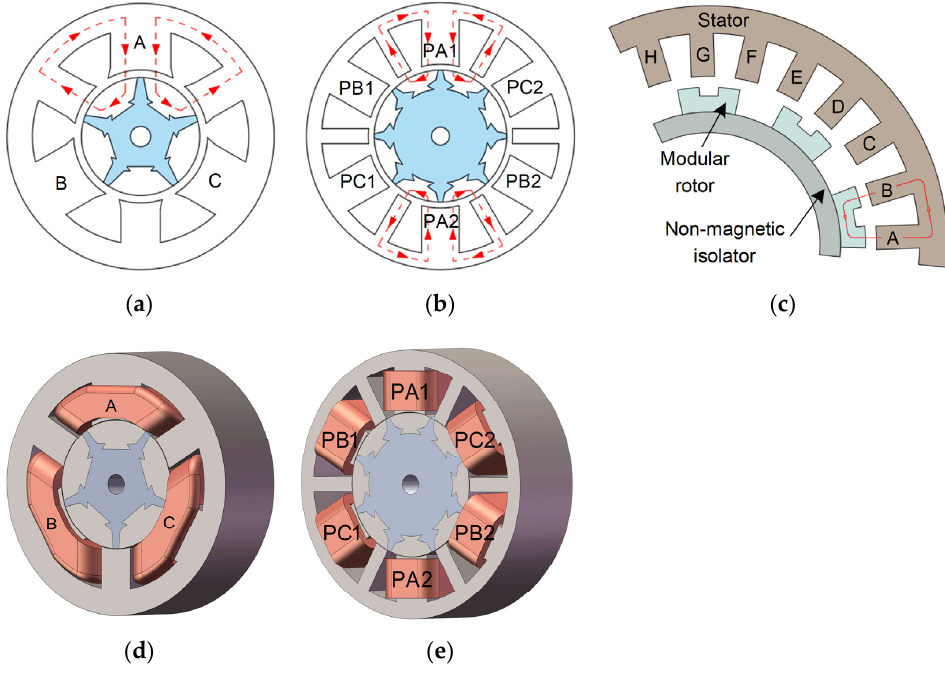
Figure 7. Proposed segmental rotor SRM with CW which used in vehicles cooling fans. ( a ) is the structure of the 6/5 segmental rotor SRM; ( b ) is the structure of the 12/8 segmental rotor; ( c ) is the 8-phase 24/18 SSRM with segmental rotors (1/3 model); ( d ) and ( e ) is the 3D model of segmental rotor SRM.